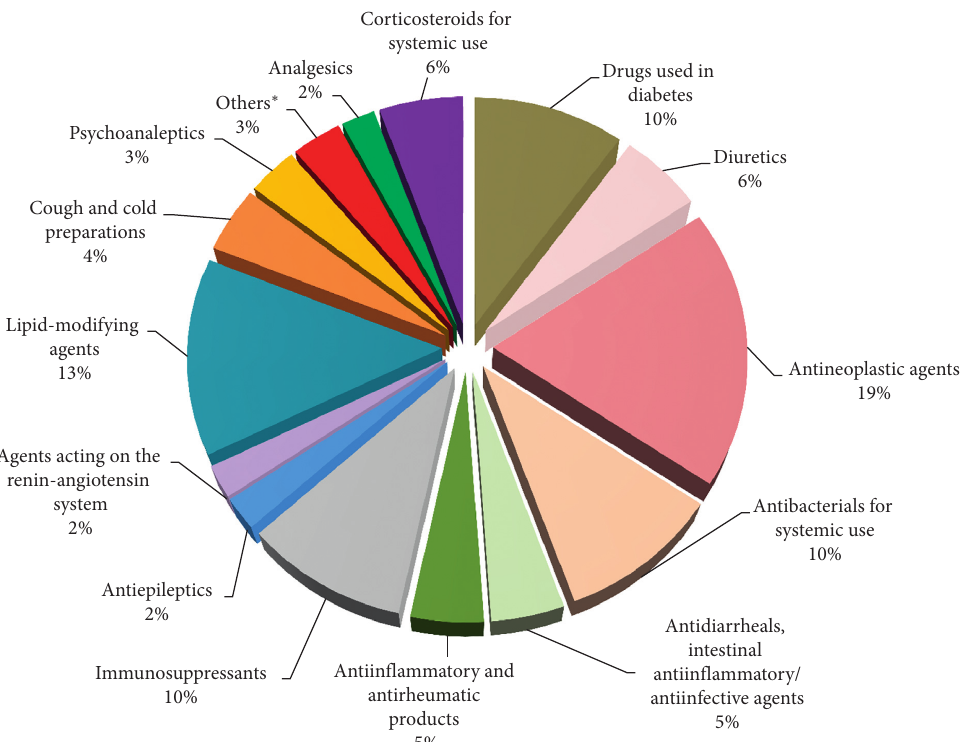
Figure 2: Distribution of drug-induced acute pancreatitis causative drug classes. Presented as percent according to the number of hospitalizations ( n � 90). ∗ Others included psycholeptics, endocrine therapy, and antimycobacterials drug